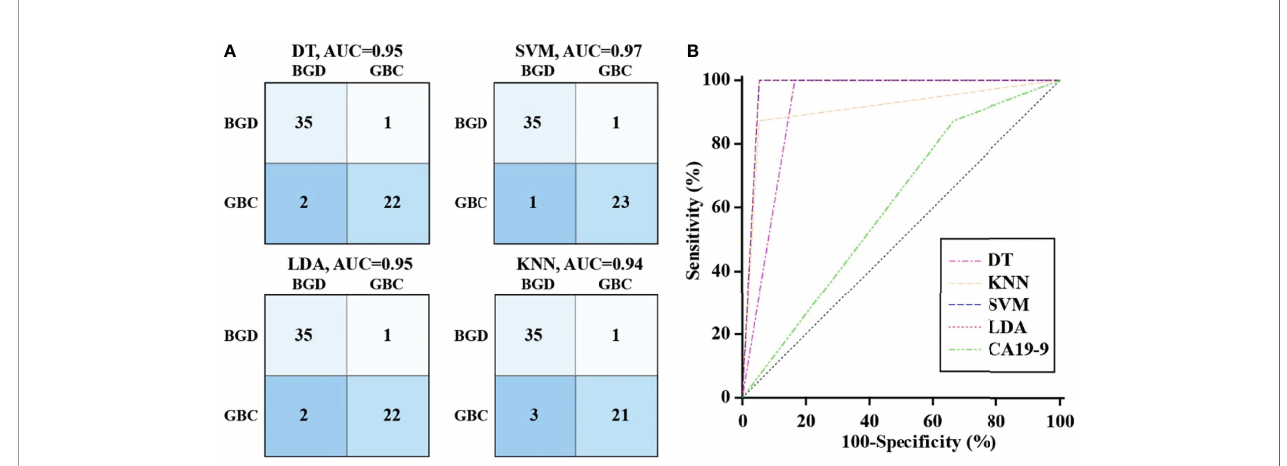
FIGURE 4 | Diagnostic performance of VOCs with machine learning algorithm. (A) The confusion matrix of models constructed by DT, SVM, LDA and KNN in the training cohort. (B) ROC curves analysis for machine learning models and CA19-9 in differentiating GBC from BGD in the test